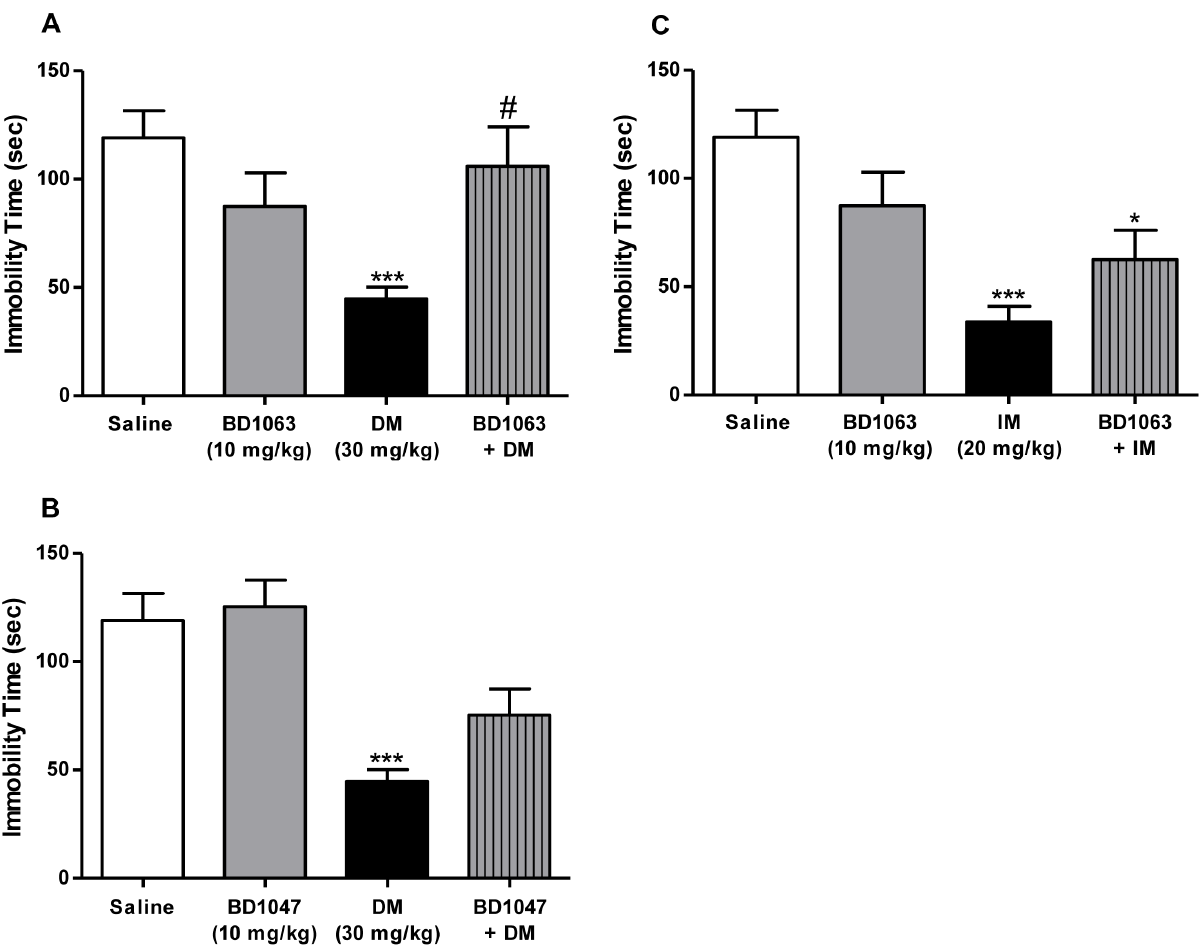
Figure 2. Attenuation of the antidepressant-like effects of dextromethorphan, but not imipramine, by s 1 receptor antagonism. Pretreatment with the s 1 receptor antagonist BD1063 (10 mg/kg, i.p.) prevented the dextromethorphan (30 mg/kg, i.p.)-induced decrease in immobility time (A). BD1047 (10 mg/kg, i.p.) pretreatment also produced a noticeable, albeit not statistically significant, trend toward the prevention of the decreased immobility time induced by dextromethorphan (B). In contrast, the antidepressant-like effect of imipramine (20 mg/kg, i.p.) in